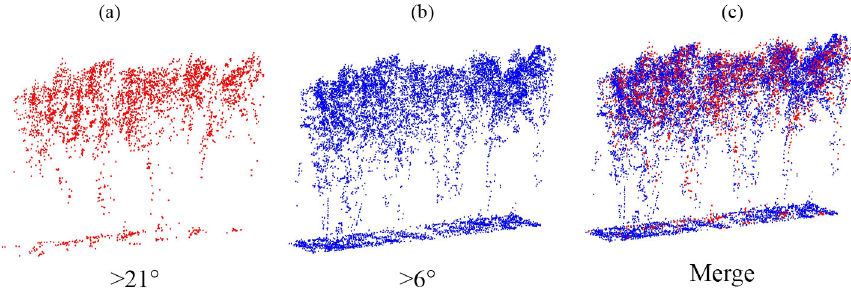
Figure 16. Scanning angle contribution schematic: ( a ) profile for scanning angles greater than 21 ◦ ; ( b ) profile for scanning angles greater than 6 ◦ ; and ( c ) combination of